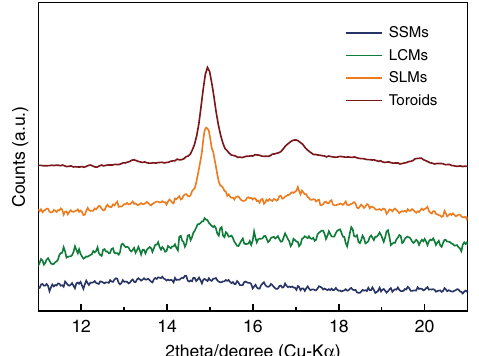
Fig. 3 Crystallinity of the intermediate assemblies. WAXS spectra for SSMs, LCMs, SLMs, and PS- b -PDLA